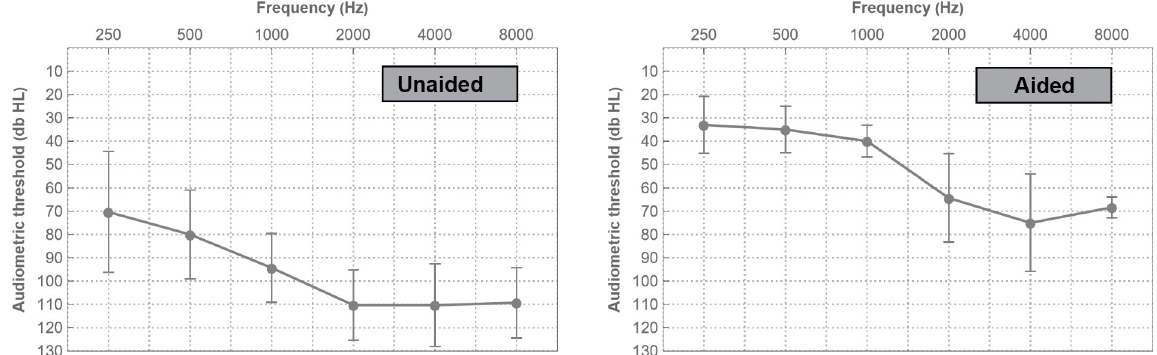
Fig 1. Mean pure-tone air conduction thresholds in the hearing aid ear for the unaided and aided situation in free field. Error bars indicate one standard deviation. https://doi.org/10.1371/journal.pone.0277161.g001 bimodal benefit was defined as the additional value of listening with CI and HA together com- pared to listening with CI alone. An overview of outcomes is shown in Table 1. Loudness and the loudness audiogram. In this study, the Adaptive Categorical Loudness Scaling (ACALOS) procedure was used, which is a fast method and does not require training thereby making it applicable for clinical use [40]. For each input frequency, test results are usu- ally presented as loudness curves relating stimulus intensity level (x-axis, dB HL) to loudness perception (y-axis, categorical units) across the subjects’ dynamic range. ACALOS was measured with CI and HA alone using the Oldenburg Measurement Applica- tions (OMA) software (Ho¨rTech gGmbH, Oldenburg). Subjects were presented with two types of stimuli: narrowband (NB) noise (with 1/3-octave bandwidth at 250, 500, 1000, 2000 Hz) and broadband (BB) noise. Results measured with NB and BB noise will be cited as ACA- LOS and ACALOS respectively. The BB signal consisted of a modification of the NB BB Table 1. Overview of study outcomes. MODALITIES BIMODAL